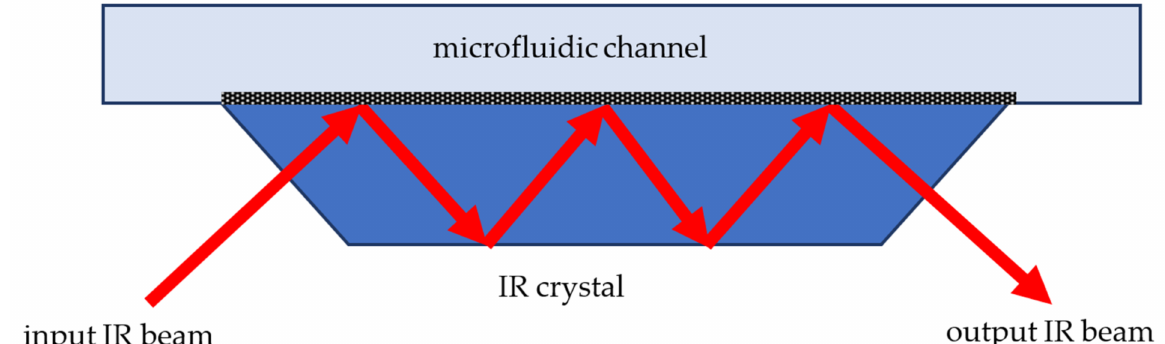
Figure 6. Measuring MIR absorption spectra using ATR setup (red arrows—IR light rays).